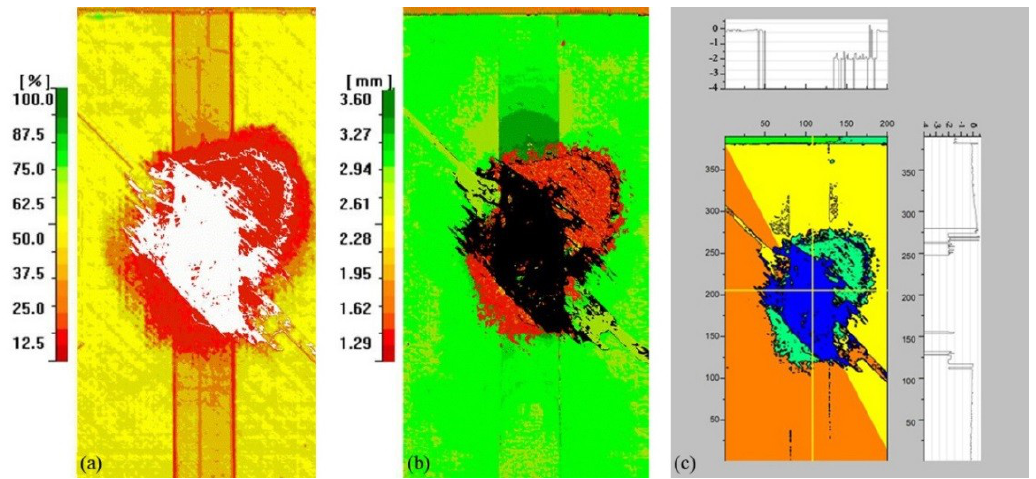
Figure 7. Echo amplitude, echo location, and location data for composite-reinforced panel without protection: ( a ) echo amplitude; ( b ) echo location; ( c ) location data (Unit: mm).